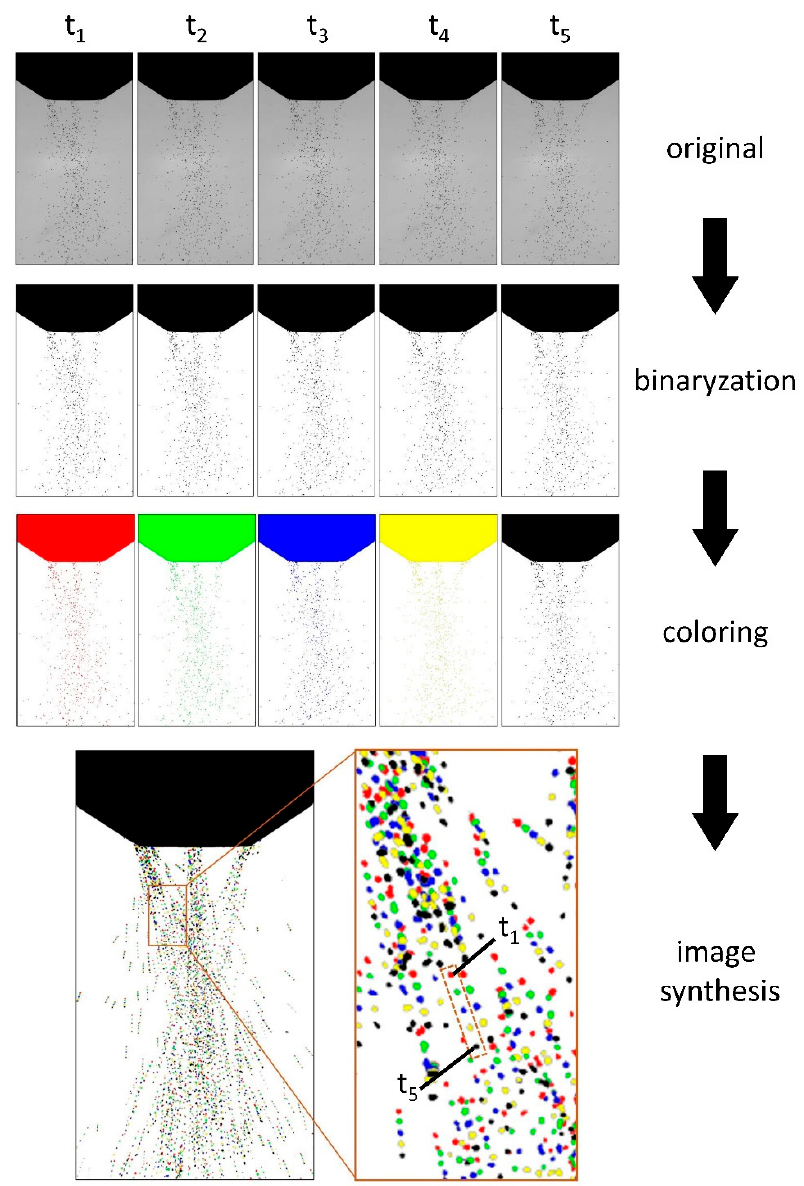
Figure 4. Measurement of particle velocity by high-speed camera (10,000 frames per second).